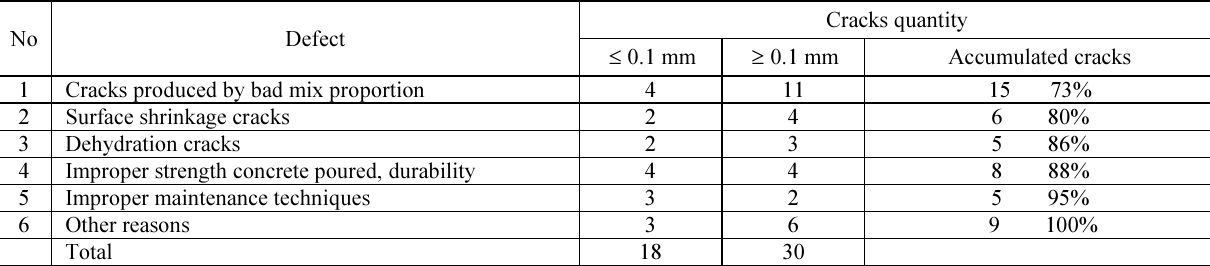
Table 1. Analysis of quality